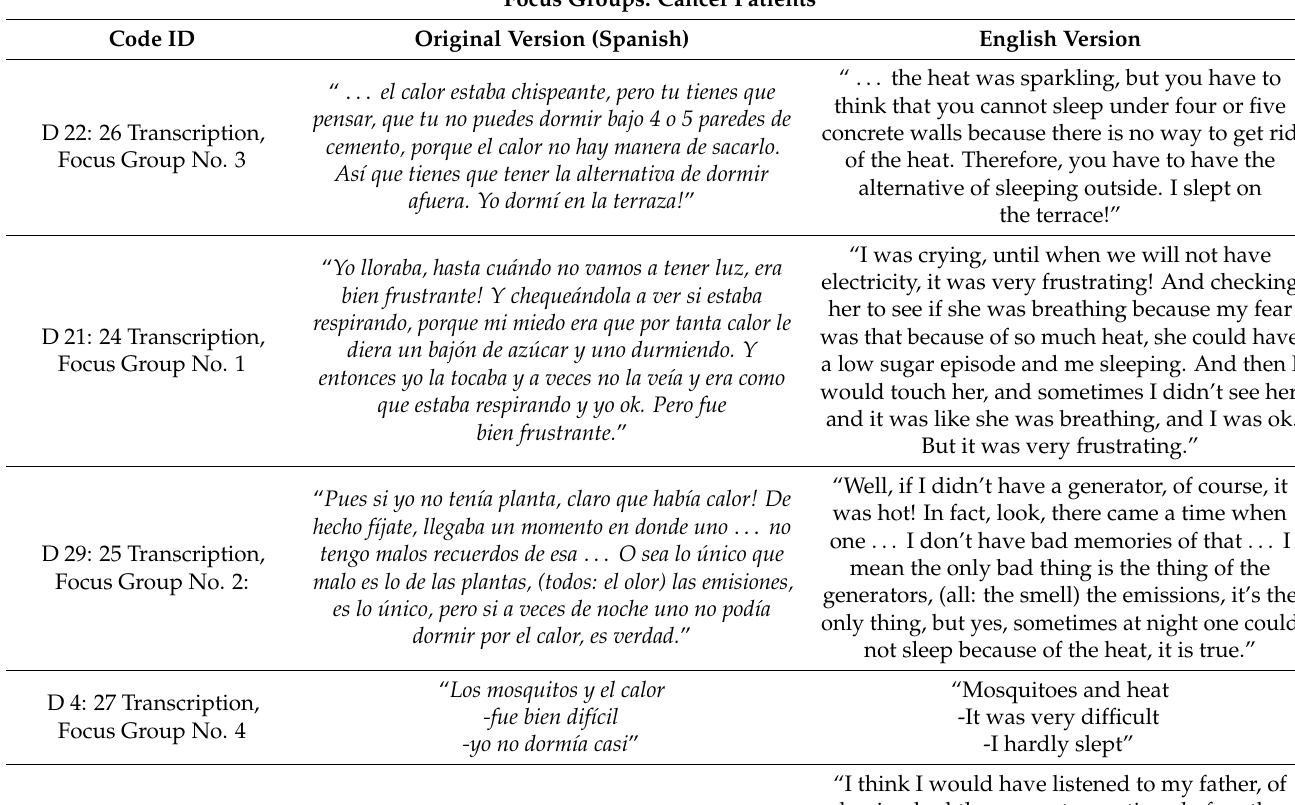
Table 2. Environmental stressors reported by GYN Cancer patients and Key-Informants. Focus Groups: Cancer